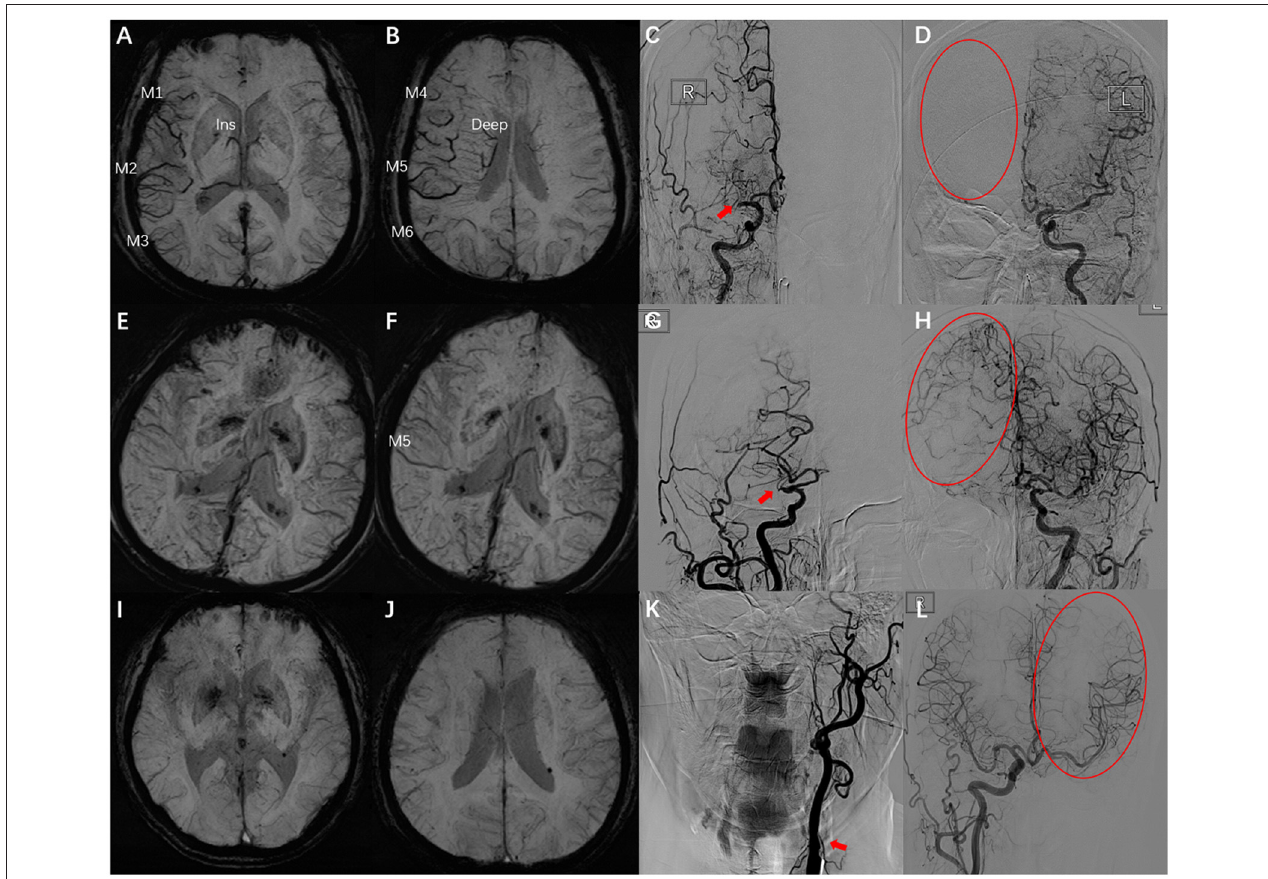
FIGURE 2 | Examples for case selection. (A,B) SWI images, ACVS in M1, M2, M3, and Ins and M4, M5, M6, and Deep were evident, ACVS grade was “severe.” (C,D) DSA images showed the right MCA was occluded in horizontal segment (red arrow), no visible CC in the ischemic site (red circle), ASITN grade = 0. (E,F) SWI images, ACVS in M5 was evident, ACVS grade is “mild.” (G,H) DSA images showed the slow CC but complete blood flow to the ischemic bed, ASITN grade = 3. (I,J) SWI images, no ACVS in any MCA cortical area, ACVS grade is “none.” (K,L) DSA images showed the left ICA was occluded in start section (red arrow), the CC is rapidly and completely perfused to the whole ischemic vascular bed (red circle), ASITN grade = 4. SWI, susceptibility-weighted imaging; ACVS, asymmetric cortical vein sign; Ins, insula; Deep, deep white matter; MCA, middle cerebral artery; DSA, digital subtraction angiography; CC, collateral circulation; ASITN, American Society of Interventional and Therapeutic Neuroradiology; ICA, internal carotid artery; red arrow: responsible vessel; red circle: collateral